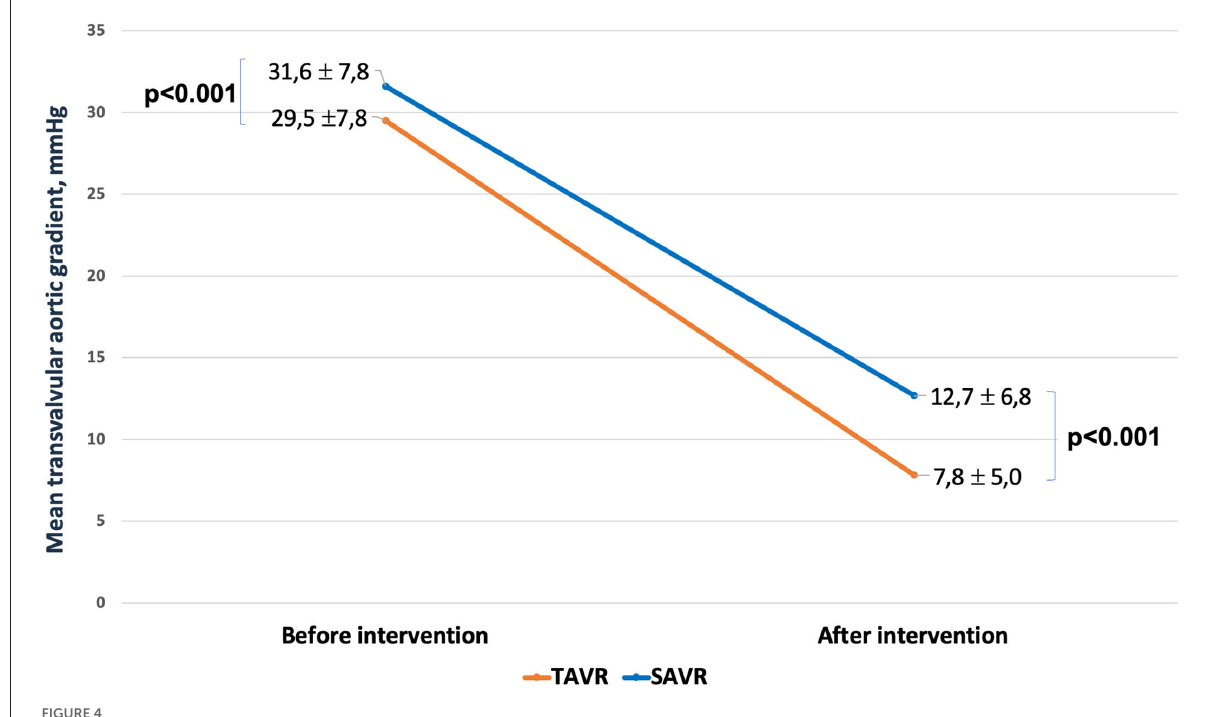
FIGURE4 Change in mean transvalvular gradient after SAVR and